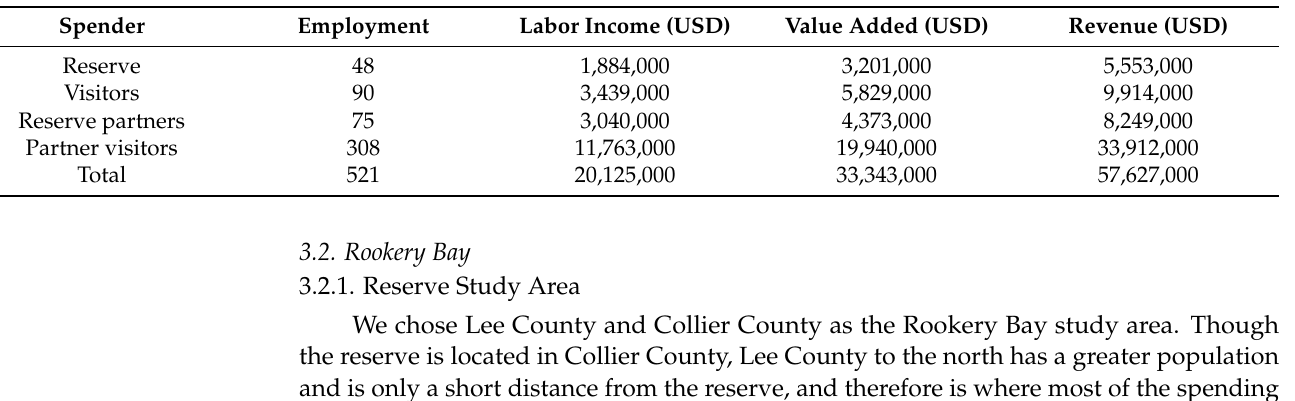
Table 3. Estimated annual contributions to employment, labor income, value added, and revenue of GTM to Duval, Flagler, and St. Johns counties by spender.